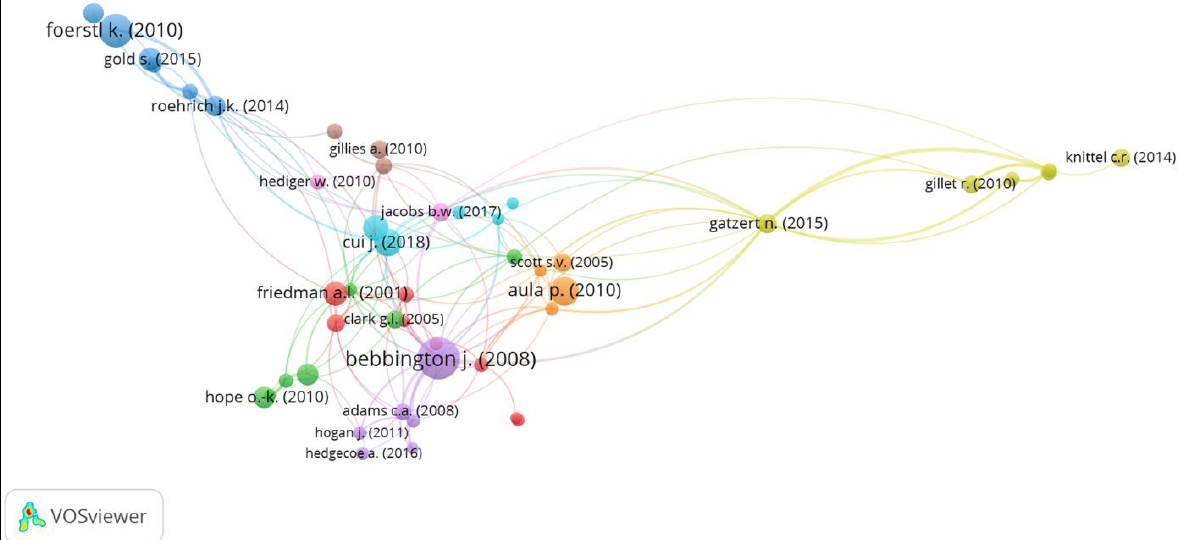
Figure 3. Top cited published reputation risk papers’ map